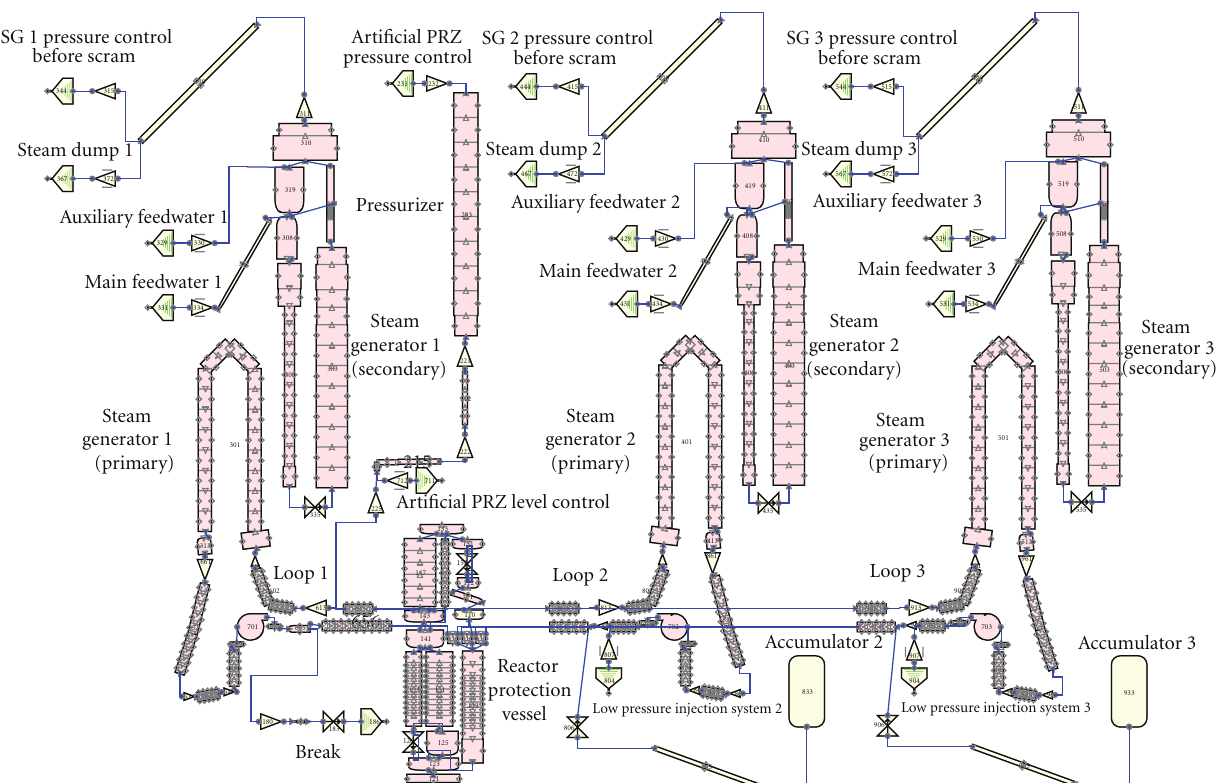
Figure 2: SNAP hydraulic components view for RELAP5/MOD3.3 input model of BETHSY 6.2TC transient.